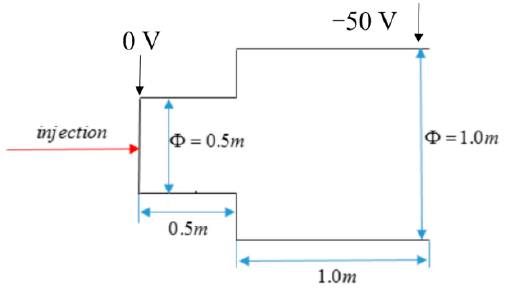
Figure 3. Geometric model.